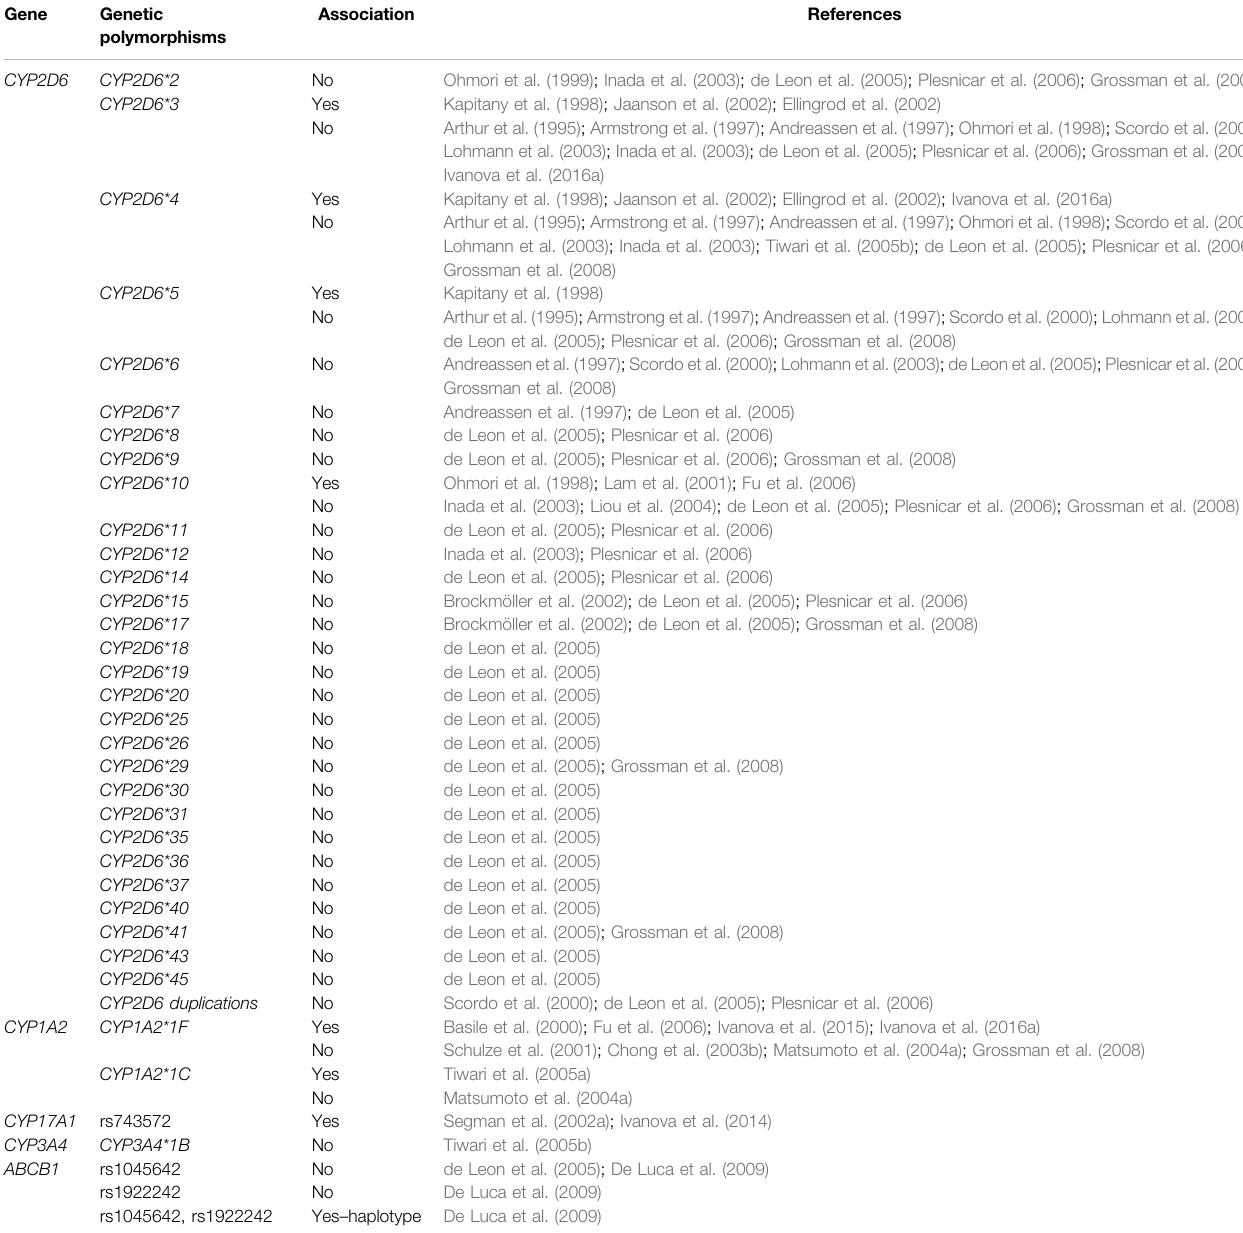
TABLE 1 | Pharmacokinetics gene polymorphisms and associations with TD. Gene Genetic polymorphisms